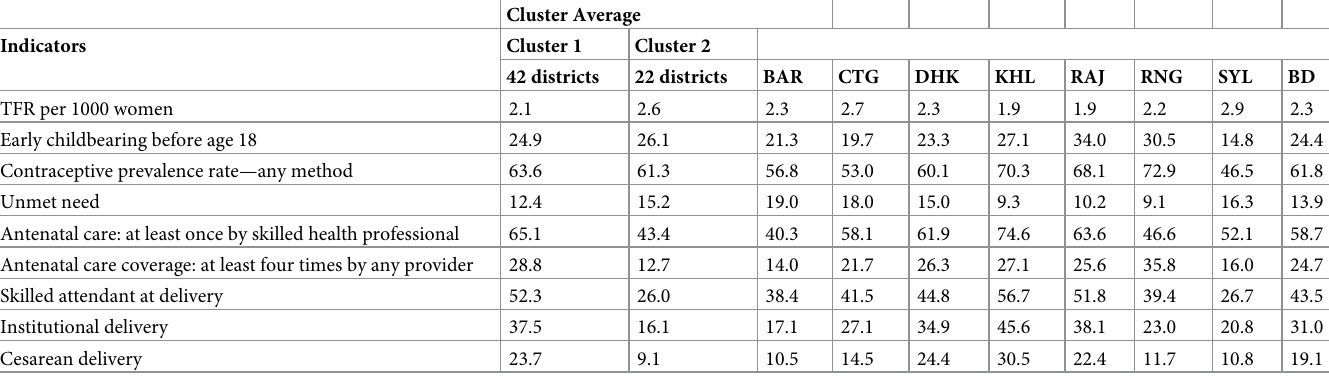
Table 4. Cluster averages of districts along with averages of the divisions and Bangladesh as a whole based on reproductive health indicators.